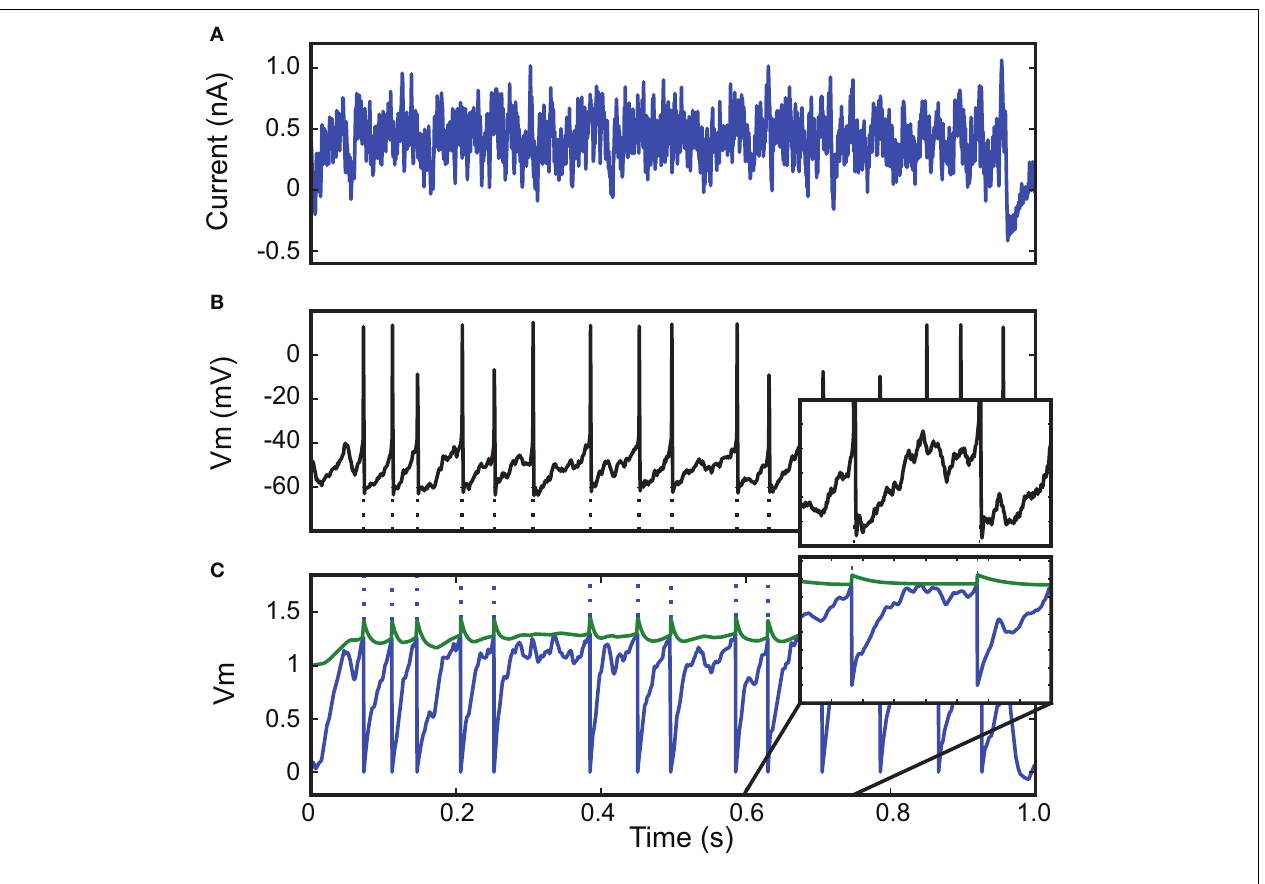
FIGURE 4 | Fitting a leaky integrate-and-fi re neuron with adaptive threshold to electrophysiological recordings. (A) A fl uctuating in-vivo -like current was injected intracellularly in the soma of a L5 fast spiking cell. (B) The